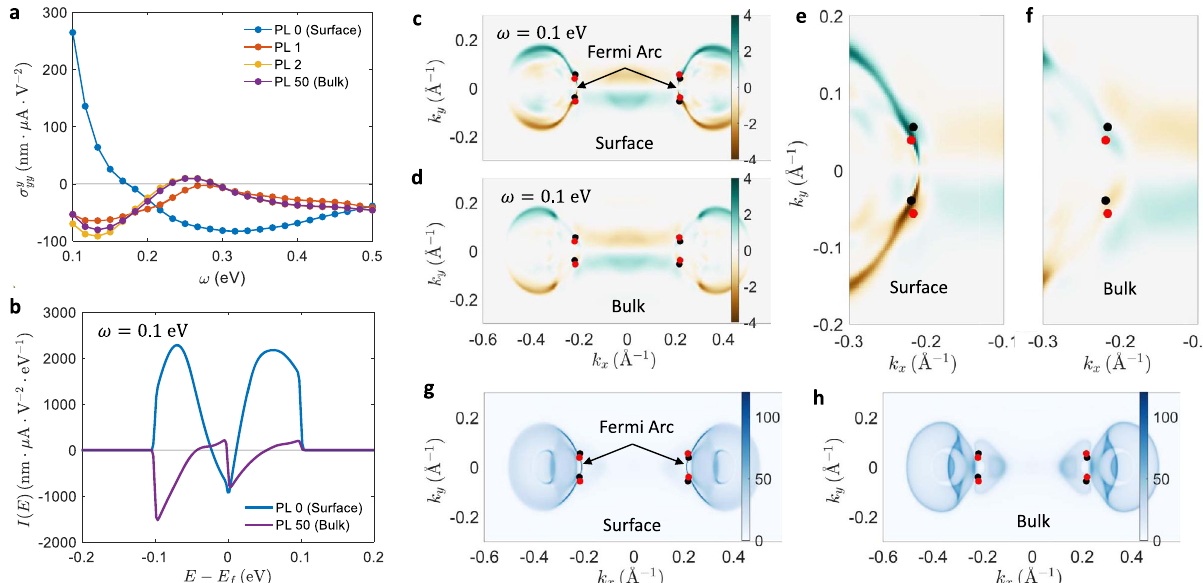
Fig. 2 BPV conductivity of T d -WTe 2 . a Layer resolved BPV conductivity for PLs from the surface to the bulk. b Energy-resolved contribution to the BPV conductivity for the surface and bulk PL for light frequency ω ¼ 0 : 1 eV . The energy-resolved contribution is de fi ned as P I E ð Þ (cid:6) (cid:2) ie 3 Tr v a G < E ð Þf g . c , d k -resolved contribution, de fi ned as I k ; E ð Þ (cid:6) (cid:2) ie 3 ω ω 2 S k and ( d ) bulk PL. e , f Same as ( c , d ), but zoomed-in around the Fermi arc. g , h Spectrum function A ð k ; E Þ at E ¼ E F for ( e ) surface and ( f ) bulk PL. The Fermi arcs are labelled by the arrows in ( c , e ). In ( c – h ) the black and red dots mark the locations of Weyl points with + 1 and − 1 chirality,